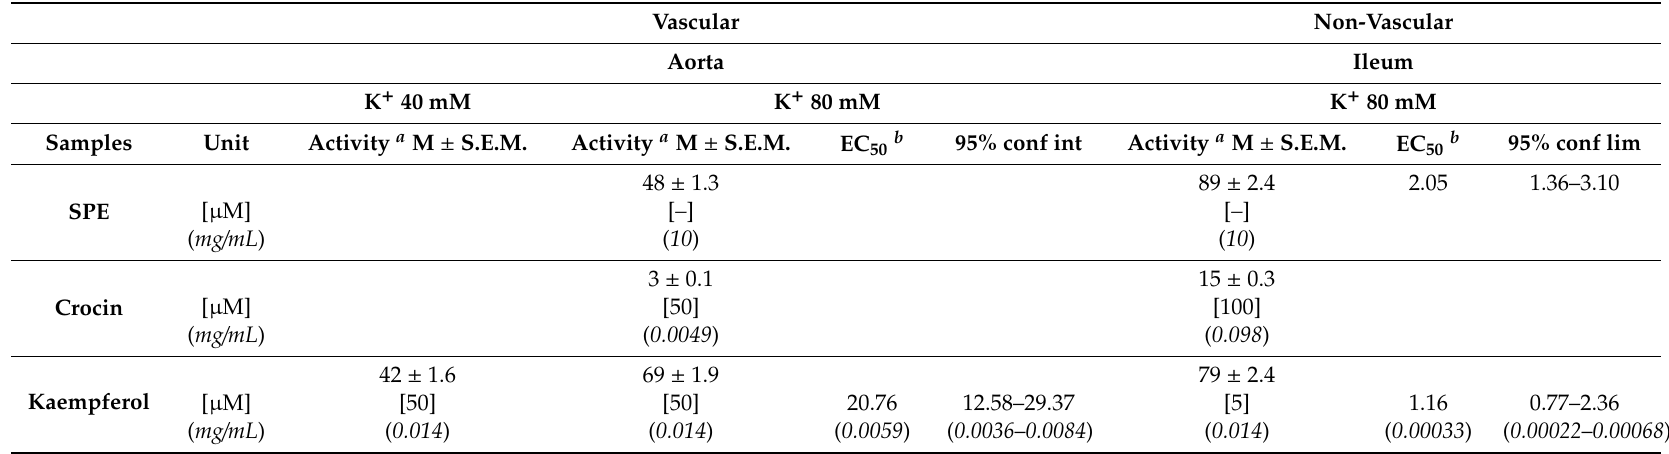
Table 3. Relaxant activity of tested samples on K + -depolarized guinea pig vascular (aortic strips) and non-vascular (ileum) smooth